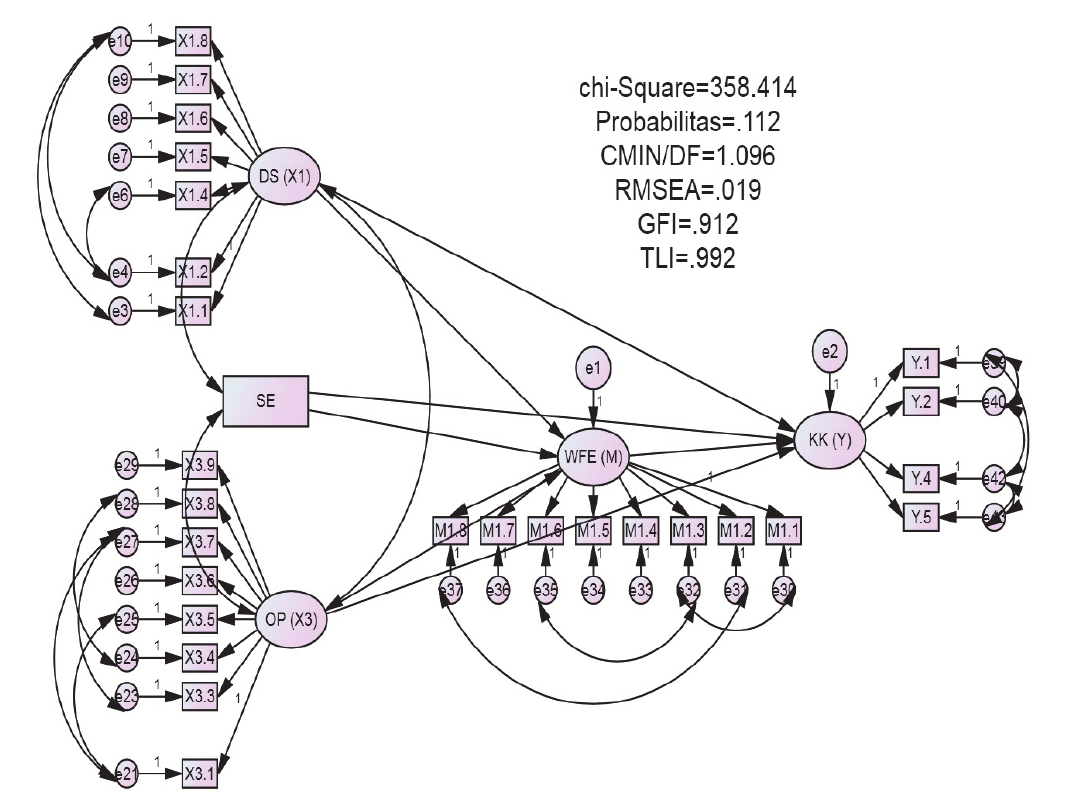
Fig. 1 . Full Model Modification Result